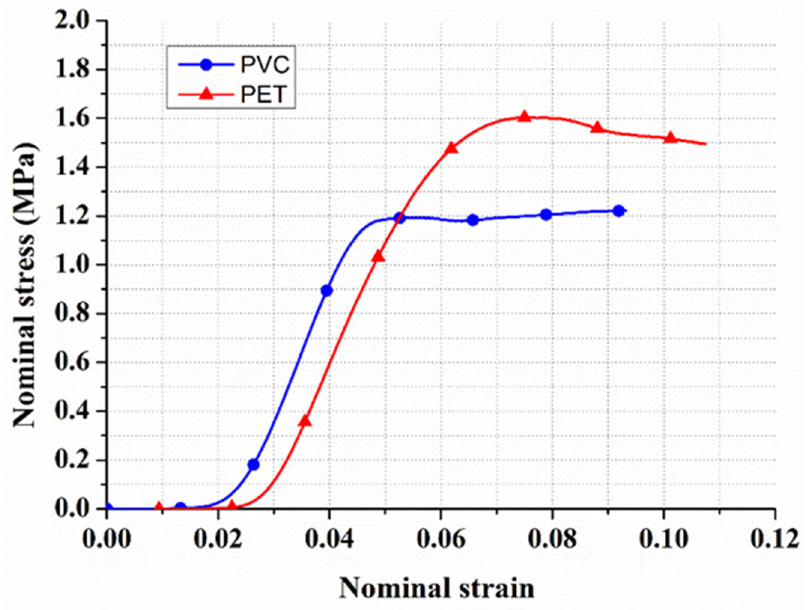
Figure 2. Nominal stress–strain curve for a compression test of PVC and PET foam.